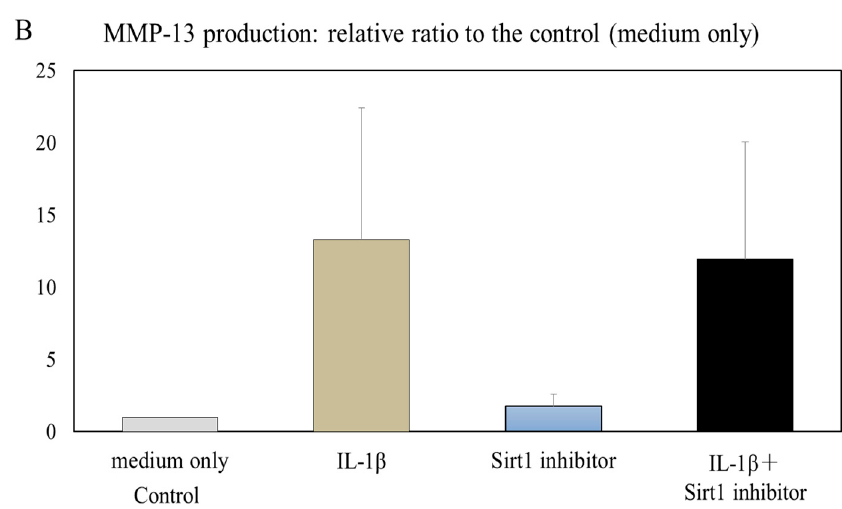
Figure 5. Sirt1 regulates Runx2 expression and MMP-13 production in osteoarthritic chondrocytes. To address whether Sirt1 is necessary to express the Runx2 protein in chondrocyte, OA chondrocytes were preincubated with Sirt1 inhibitor (S)-35 (0.5, 1.0, 5.0 µ M). ( A ) In OA chondrocytes, treatment with IL-1 β stimulated the expression of Runx2 (lane 1, 3, 5) compared to the control (lane 7). Sirt1 inhibitor inhibited the IL-1 β -induced acceleration of Runx2 expression in chondrocytes (lane 2, 4, 6); ( B ) Treatment with IL-1 β significantly accelerated MMP-13 production from chondrocytes in comparison with the control (medium only) ( p = 0.037). Treatment with Sirt1 inhibitor only did not influence the MMP-13 production from chondrocytes in comparison with the control. The inhibition of Sirt1 with Sirt1 inhibitor trended to inhibit the IL-1 β -accelerated production of MMP-13 in chondrocytes, although no significant difference was observed between the Sirt1 inhibitor-treated IL-1 β -treated chondrocytes and the Sirt1 inhibitor + IL-1 β -treated chondrocytes ( p = 0.832). The levels of MMP-13 production in both Sirt1 inhibitor-treated group and control group were lower than in those IL-1 β -treated groups.